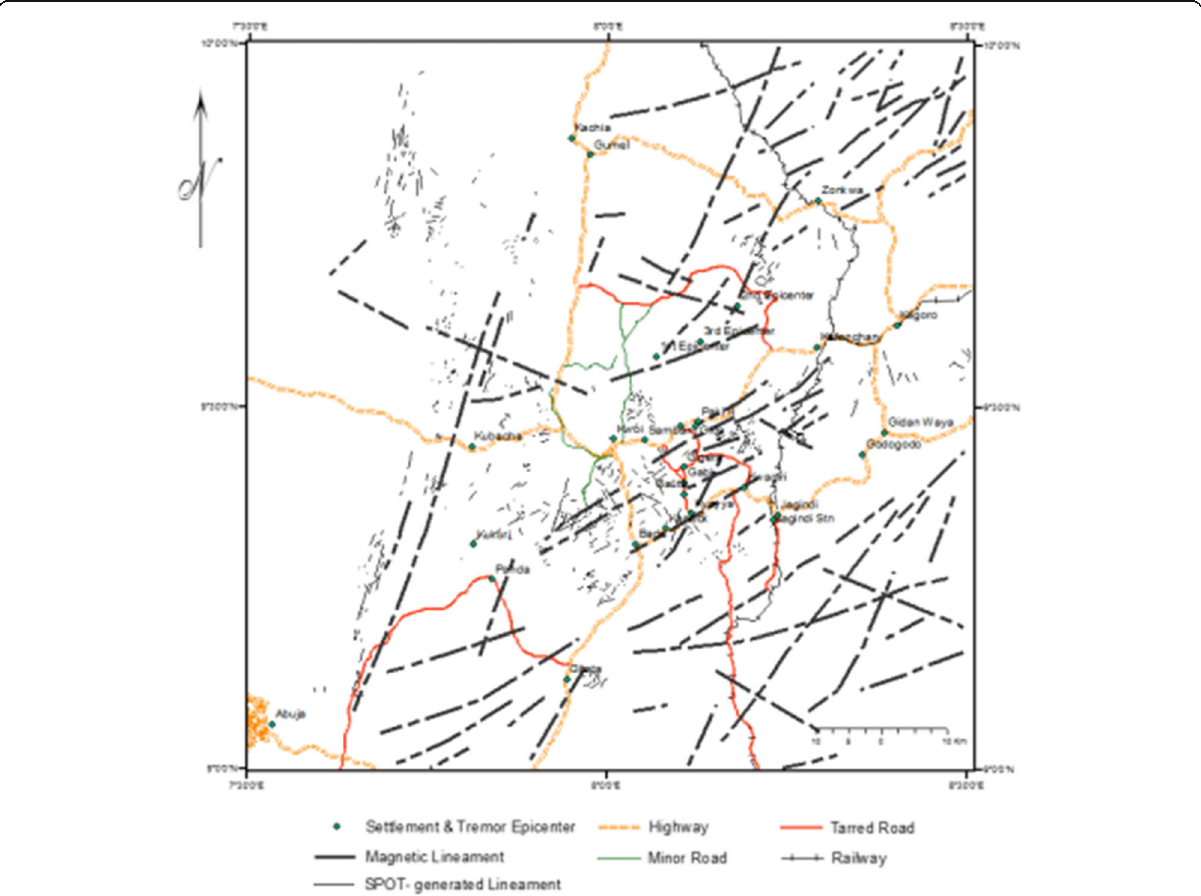
Fig. 10 Map of the area showing the lineaments and location of the epicentres of the tremors. Major lineaments mapped from aeromagnetic data show major intersections between NW-SE and NE-SW trends